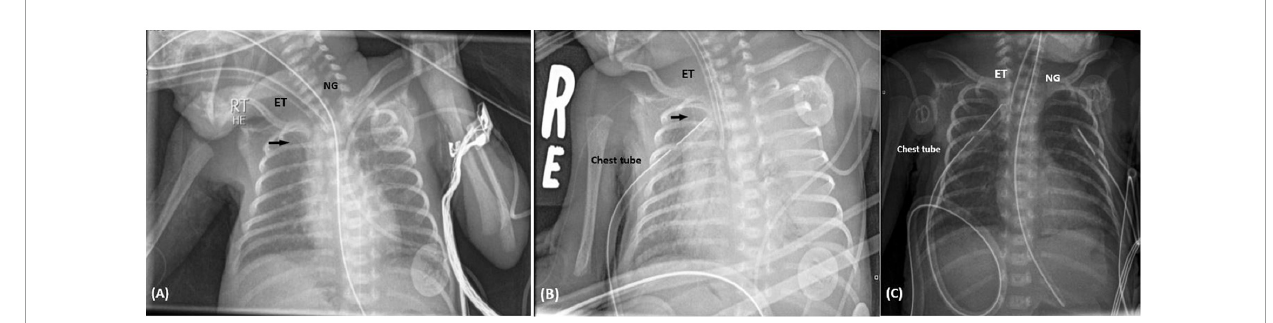
FIGURE1 (A) Supine chest radiograph following PICC insertion in Case I. Chest X-ray performed in supine position, revealed the PICC inserted through the right basilic vein reaching the left subclavian vein. According to this image, the PICC was retracted 2.5 cm. The black arrow identifies the PICC. NG, nasogastric tube; ET, endotracheal tube. (B) Supine chest radiograph following the sudden deterioration in clinical status. Chest X-ray was carried out when the patient had sudden cardiopulmonary decompression. It revealed total whitening of the left lung, as shown on the left side of the image, representing total collapse with left sided pleural effusion. The PICC is represented by the black arrow. ET, endotracheal tube. (C) Chest imaging 2 days following chest tube insertion. Chest X-ray showed complete resolution of the pleural effusion, and normal aeration of the left lung. NG, nasogastric tube; ET, endotracheal